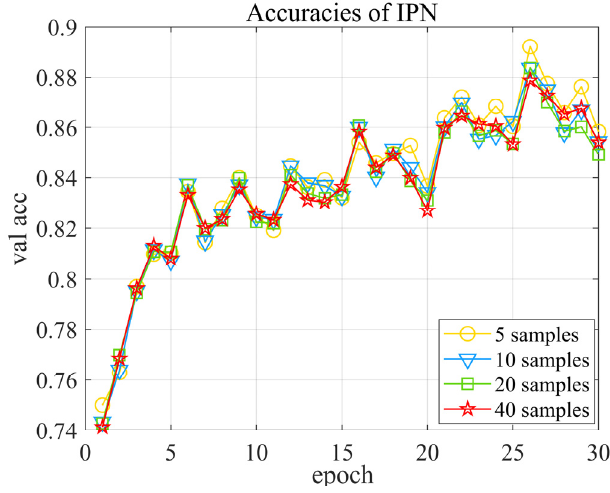
Figure 10. Validation accuracy of IPN with different query samples. Table 9. Classification accuracies on closed-set few-shot recognition with different support set samples the 3-way K-shot mean accuracy of IPN by varying the number of shots (K = 1, 5, 10, 20, 40). For each test setting, the best result is